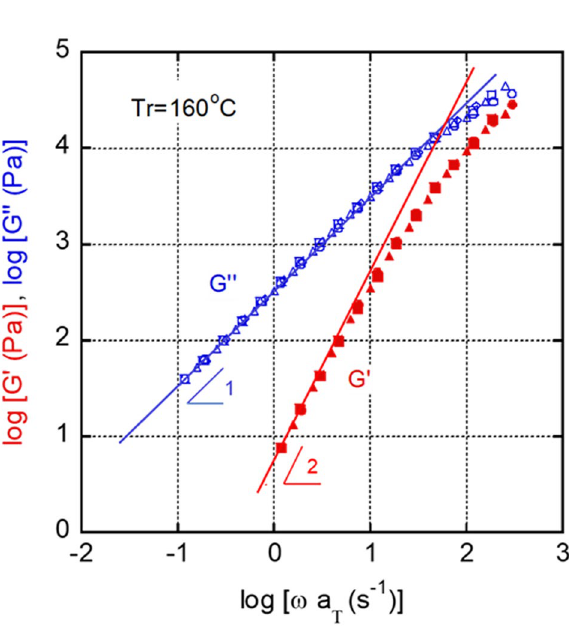
Figure 2. Master curves illustrating the frequency dependencies of the shear storage modulus G ′ and the loss modulus G ″ . The reference temperature T r was 160